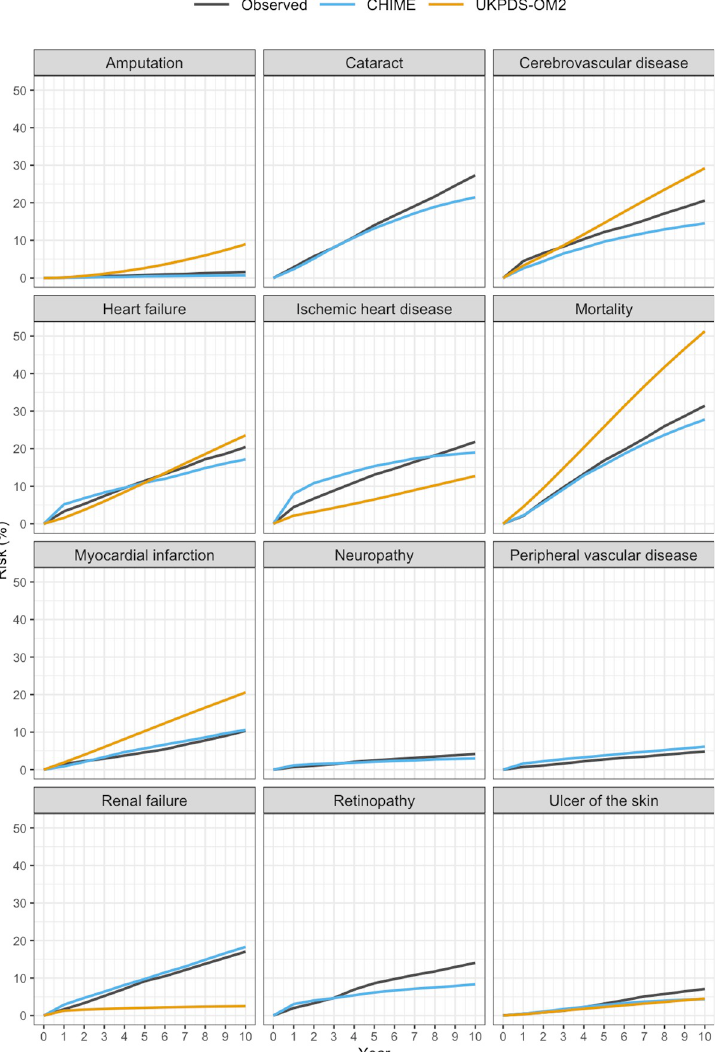
Fig 3. Validation of CHIME and UKPDS-OM2 models against CMS cohort. Predicted event rates from UKPDS and CHIME models against the observed events rates over time for CMS participants with diabetes. CHIME, Chinese Hong Kong Integrated Modeling and Evaluation; CMS, Clinical Management System; UKPDS-OM2, UK Prospective Diabetes Study Outcomes Model 2.